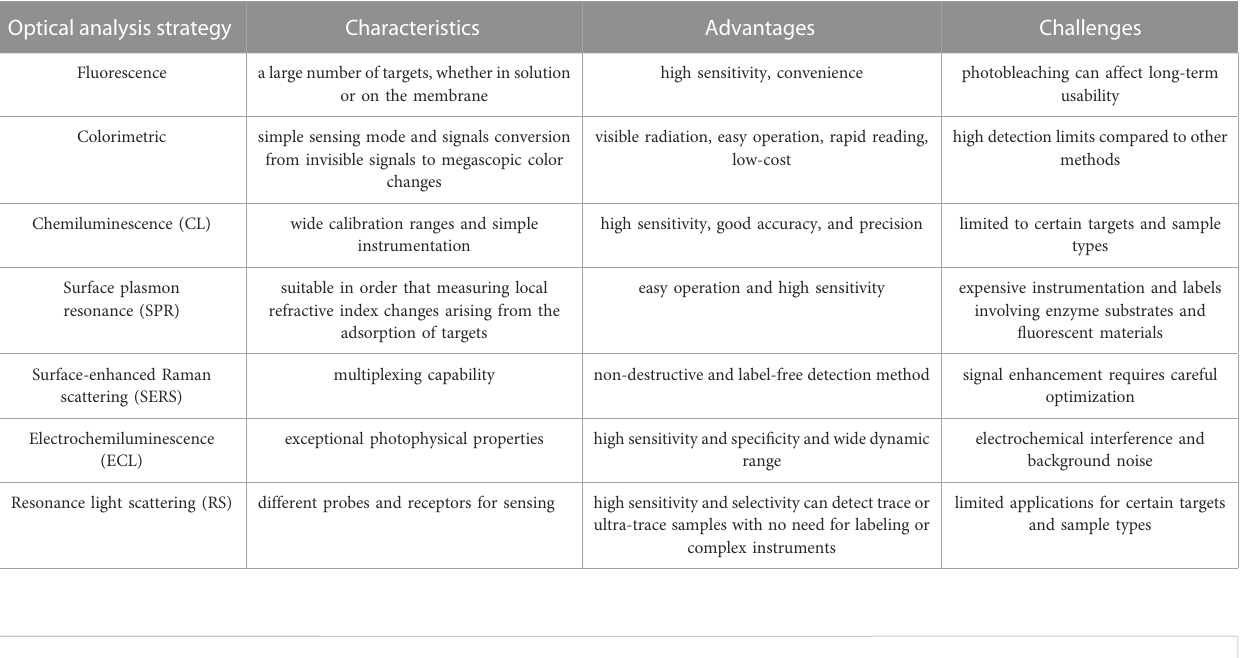
TABLE 3 | Summary and comparison of different aptasensor